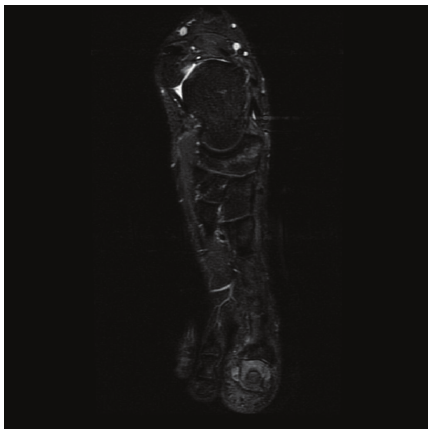
Figure 3: Preoperative coronal T1-weighted MR image of the left foot.